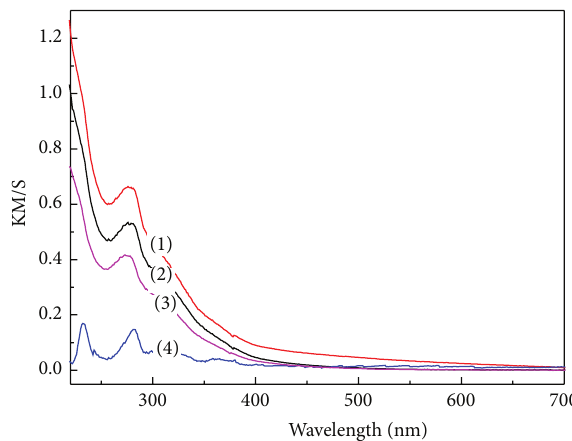
Figure 1: DRS in Kubelka-Munk units versus wavelength of TiO 2 sputtered (8 min) on polyethylene: (1) pretreated with UVC 1 torr, (2) pretreated with RF air plasma, (3) pretreated with RF plasma, and (4) TiO 2 sputtered on PE for 1